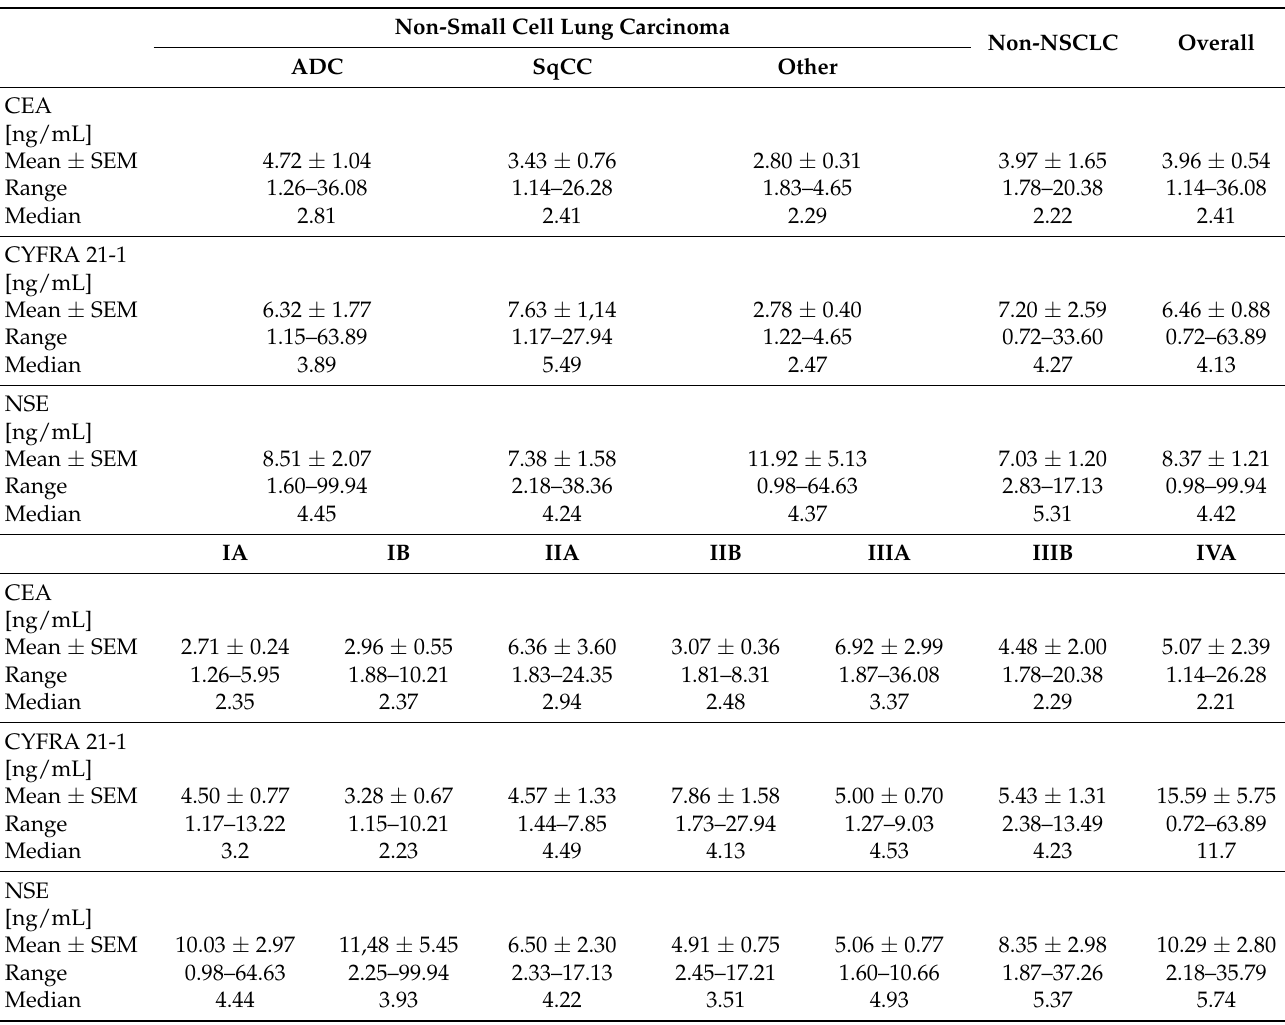
Table 2. Levels of the tumor markers according to lung cancer type, subtype, and stage.